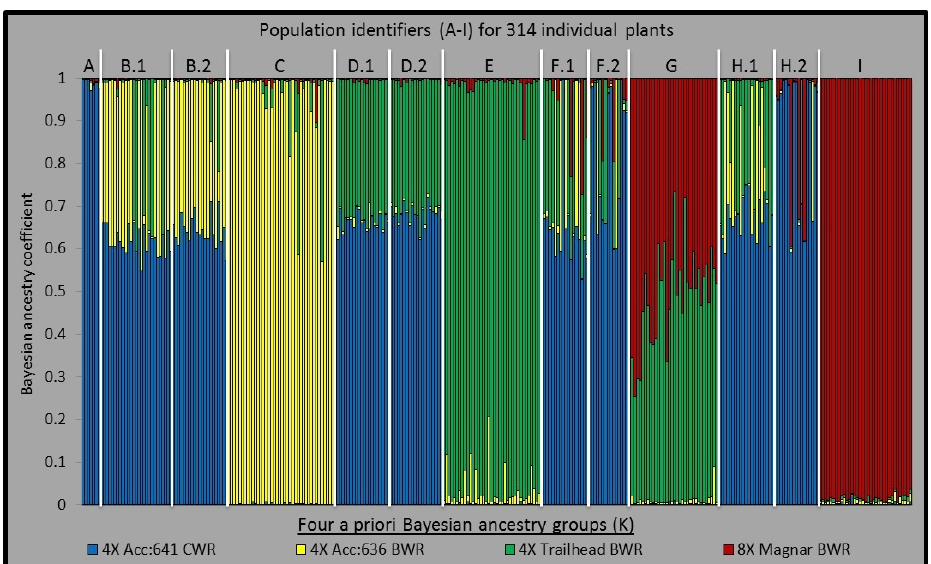
Figure 2. Bayesian cluster analysis of DNA genotypes from 314 individual plants of creeping